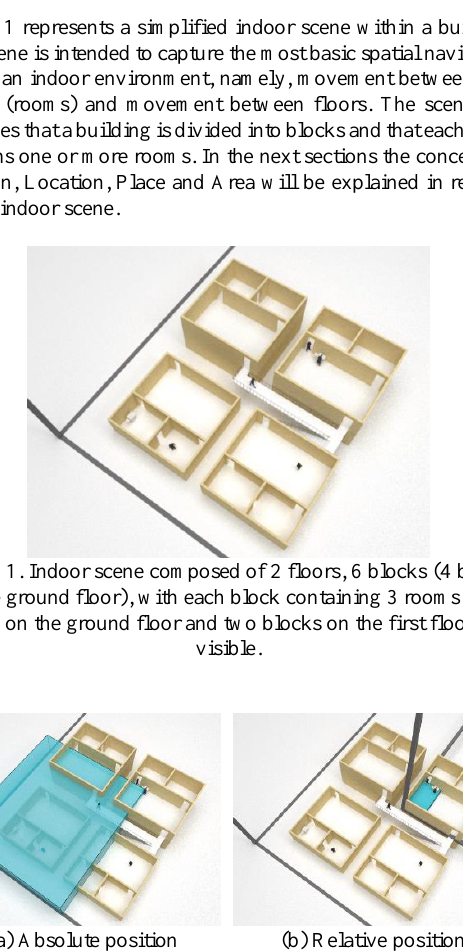
Figure 1 represents a simplified indoor scene within a building.